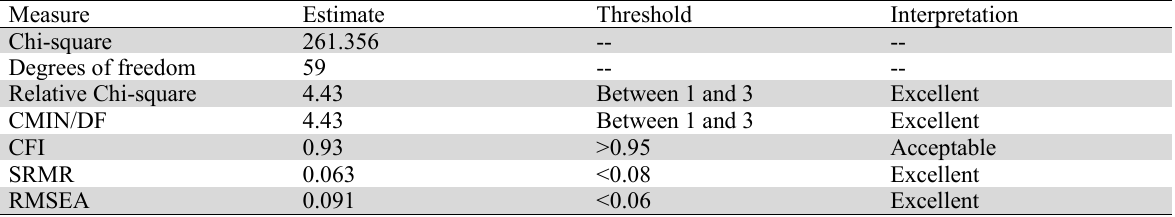
Goodness of fit indices for the measurement model